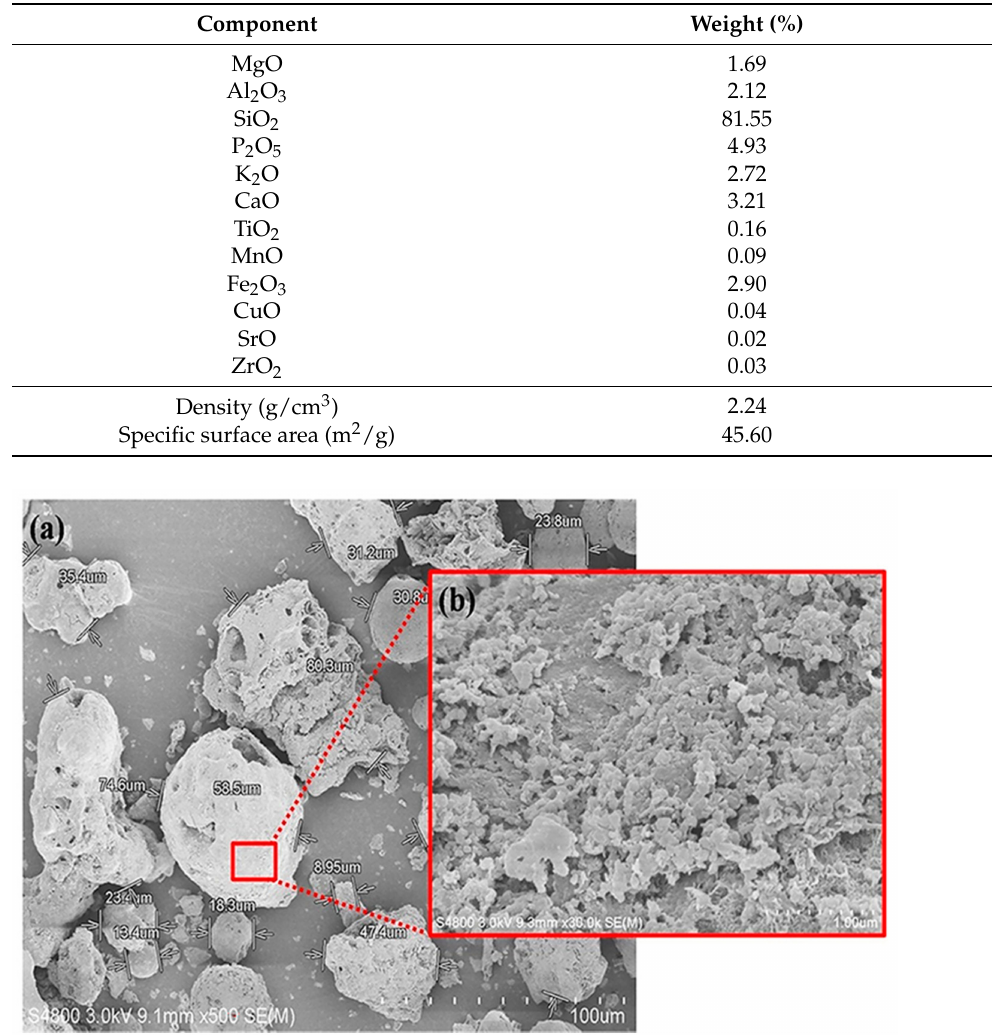
Table 1. Chemical composition of fine OPA powder.